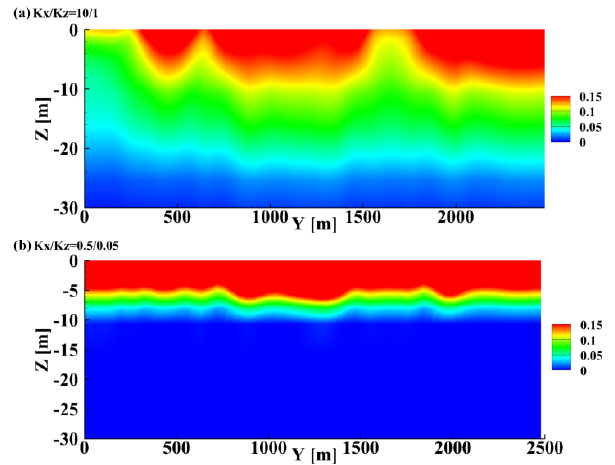
Figure A5. Contours (color scale on the right) of the maximum vertical hydraulic gradients ( i z ) at X = 450m (shoreline location) for (a) K z = 1 and (b) K z = 0 . 05 as a function of vertical Z and alongshore Y